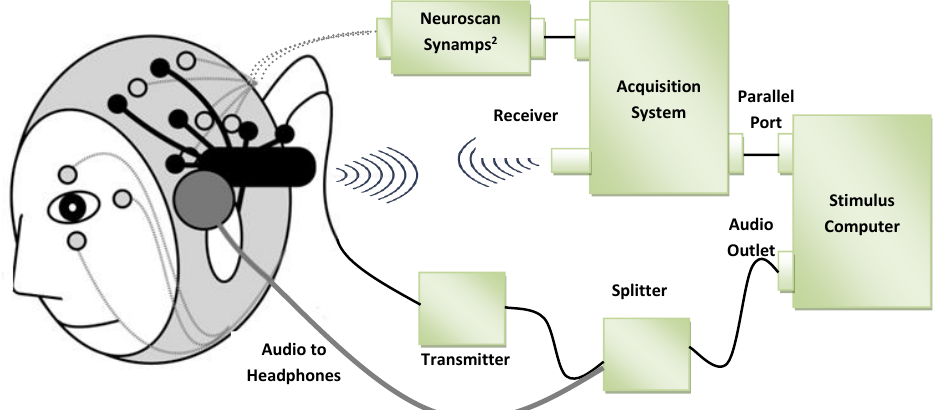
Figure 5. Connections and measurement via an EEG device